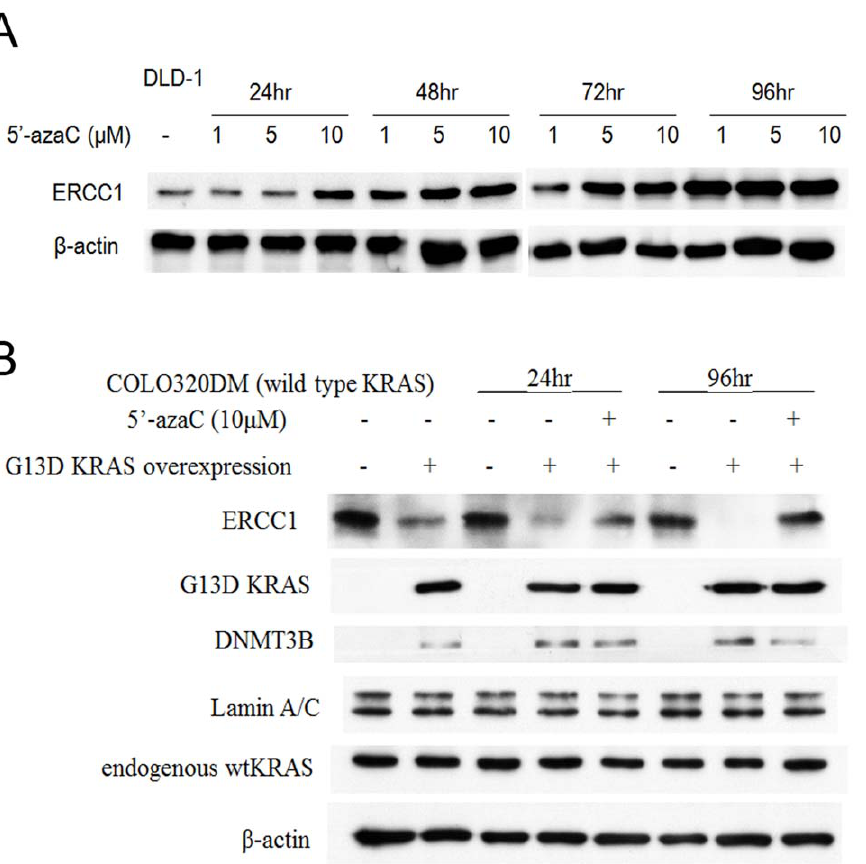
Figure 6. Downregulation of ERCC1 expression in KRAS-mutant CRC cells might be related to hypermethylation of ERCC1gene, which possibly induced by up-regulation of DNMT3B (DNA methyltransferase 3B). (A) Protein expression of ERCC1 in DLD-1(KRAS G13D mutation) cells is up-regulated after 5 9 -azacitidine (de-methylating agent) treatment for 96 hours, which implied that the downregulation of ERCC1 in KRAS-mutant CRC cells might be partly through ERCC1 hypermethylation. (B) Downregulation of ERCC1 in COLO320DM (KRAS wild-type) cells transfected by KRAS G13D -mutant-vector for 24 and 96 hours may not only be restored by 5 9 -azacitidine in 10 m M, but also caused up-regulation of DNMT3B.